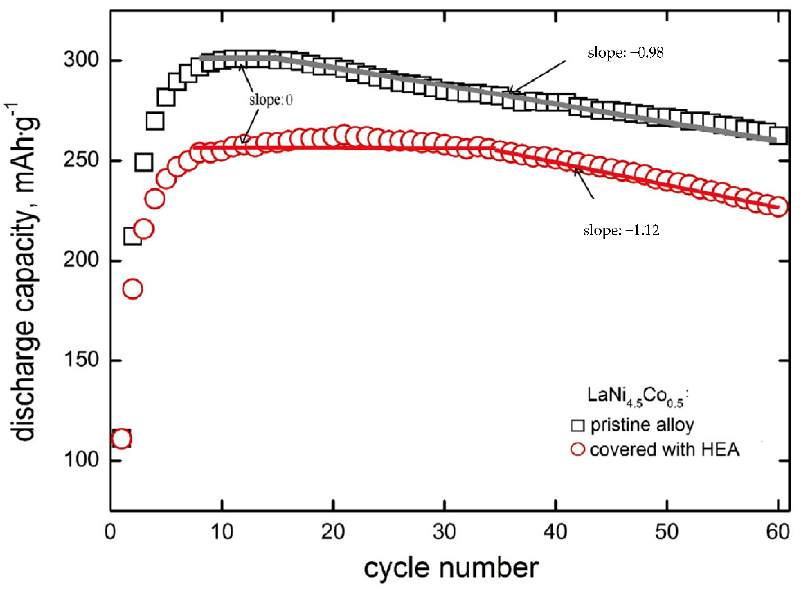
Figure 4. Discharge capacities as a function of cycle number for electrodes made of based LaNi 4.5 Co 0.5 powder material and material modified with HEA.